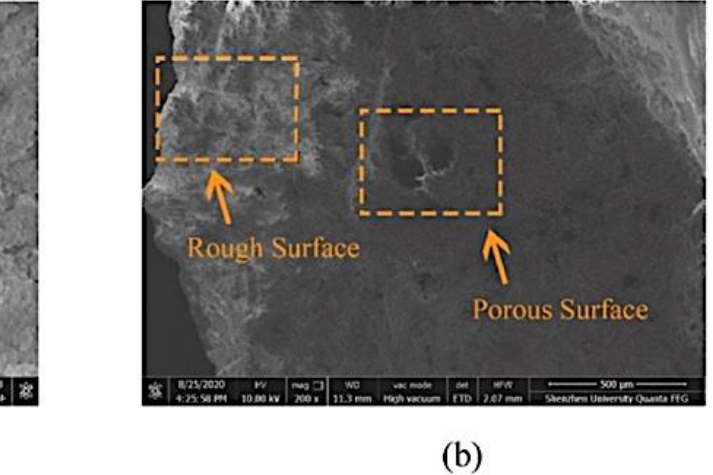
Figure 10. SEM image of ( a ) MSWI-FA and ( b ) FNS [55].